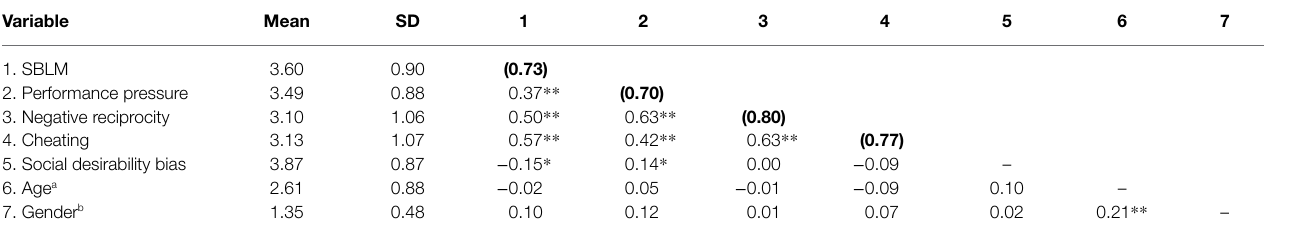
TABLE 6 | Descriptive Statistics, Correlations, and AVE Values (Study 2).